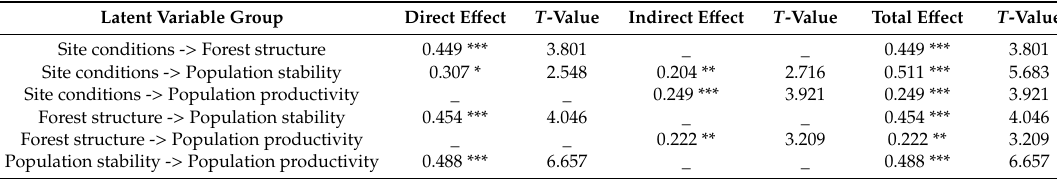
Table 6. Path coe ffi cient between latent